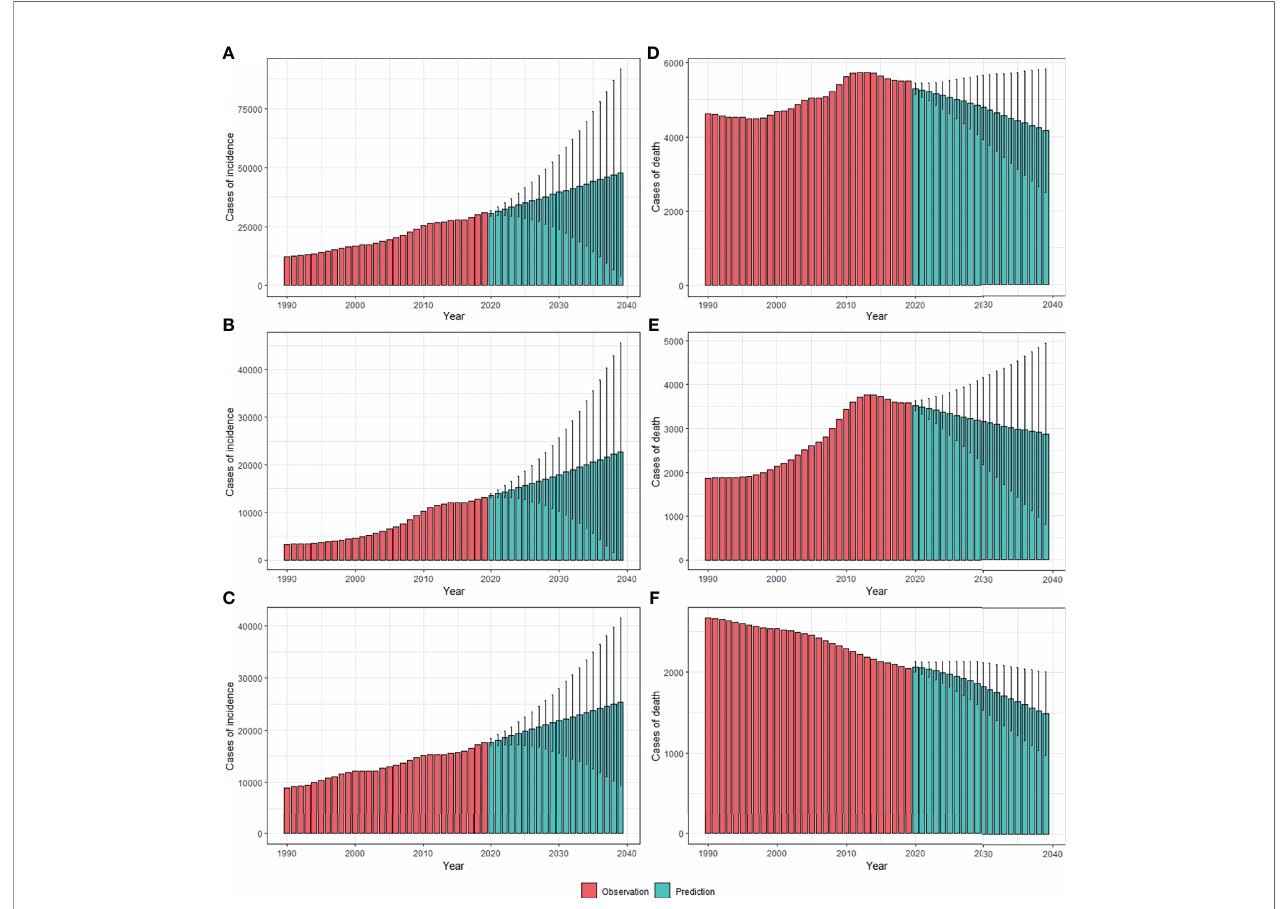
FIGURE 5 | The projections of incidence number (A – C) and deaths (D – F) in total population, men and women of thyroid cancer from 2020 to 2039 in China. The error bar denotes the 95% credible interval of the predictive